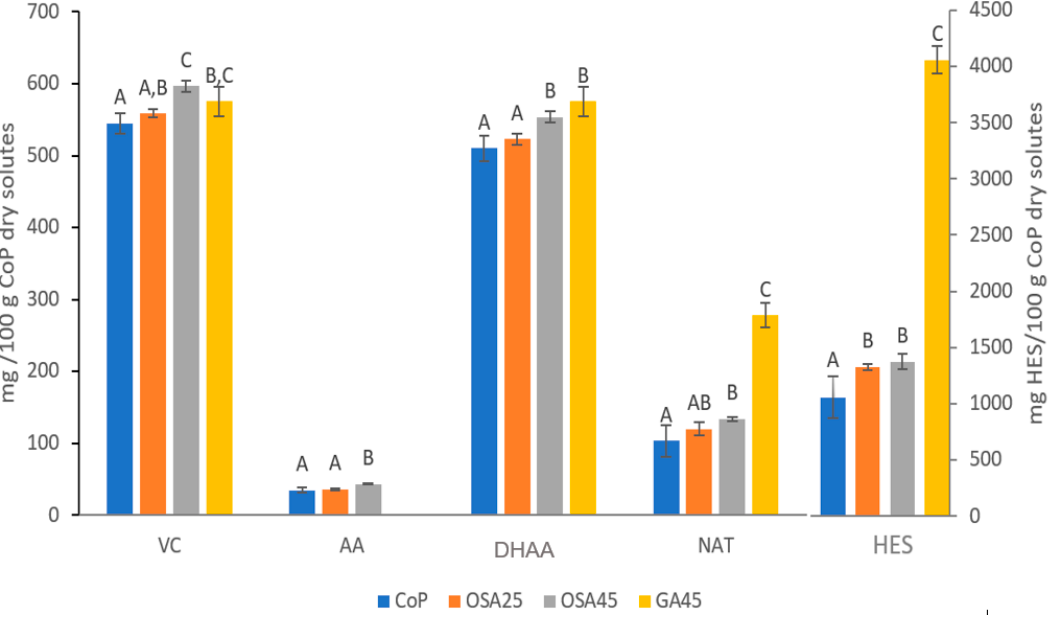
Figure 1. Bioactive compound content of the samples before freeze-drying (mg/100 g CoP dry solutes). VC: vitamin C; AA: ascorbic acid; DHAA: dehydroascorbic acid; NAT: narirutin; HES: hesperidin. For each com-pound, different letters (A–C) indicate different homogeneous groups established by Tukey HSD ANOVA ( p <